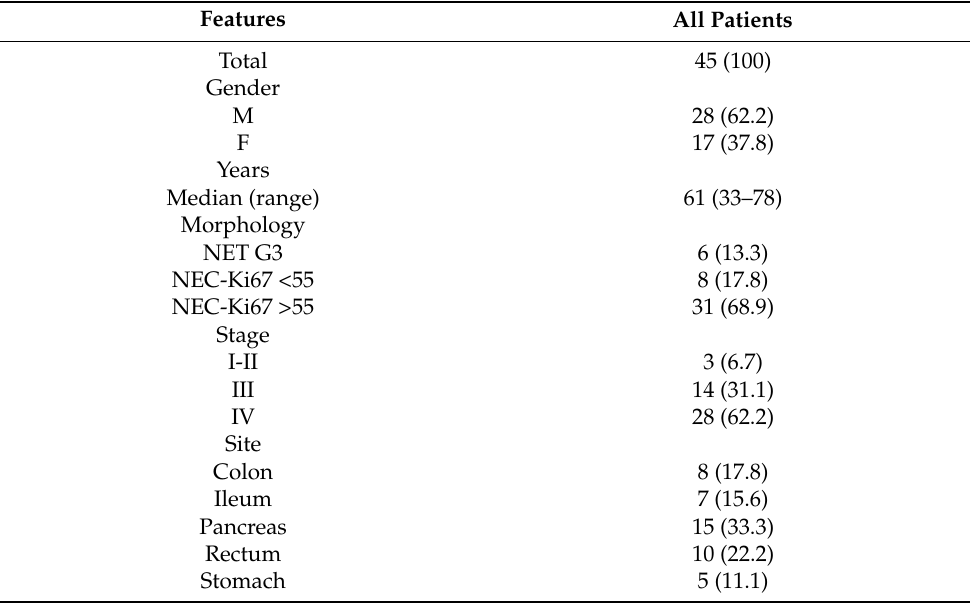
Table 1. Clinicopathological features of the 45 patients included in the study.